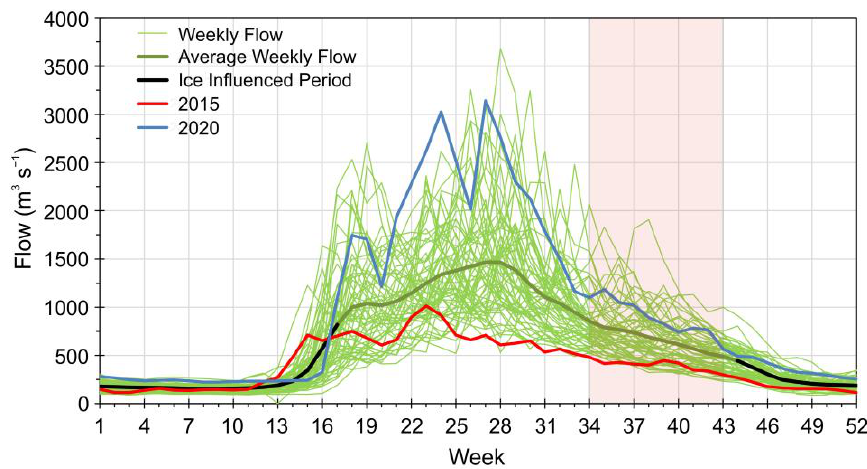
Figure 3. Observed historical flow for the Athabasca River just below Fort McMurray (07DA001) for 1958 to 2020. Each green line corresponds to one year of flow in weekly averages, with the long-term mean highlighted in bold green line and the fall navigability period in transparent red.